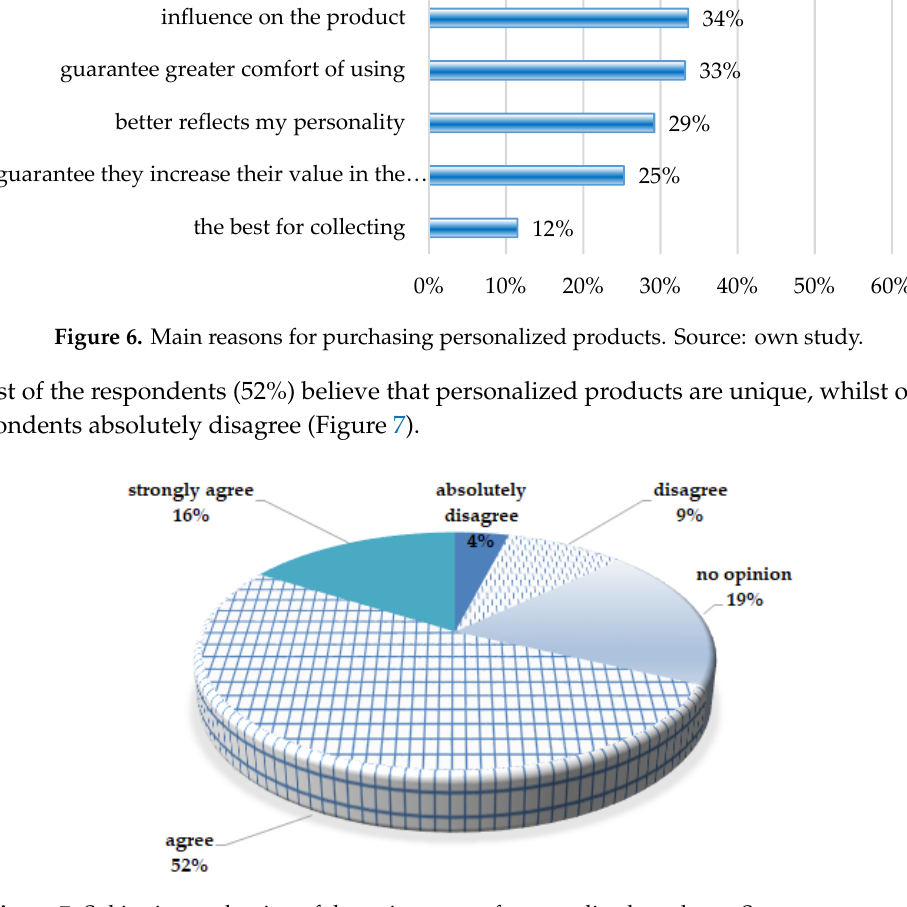
Figure 7. Subjective evaluation of the uniqueness of personalized products. Source: own study.